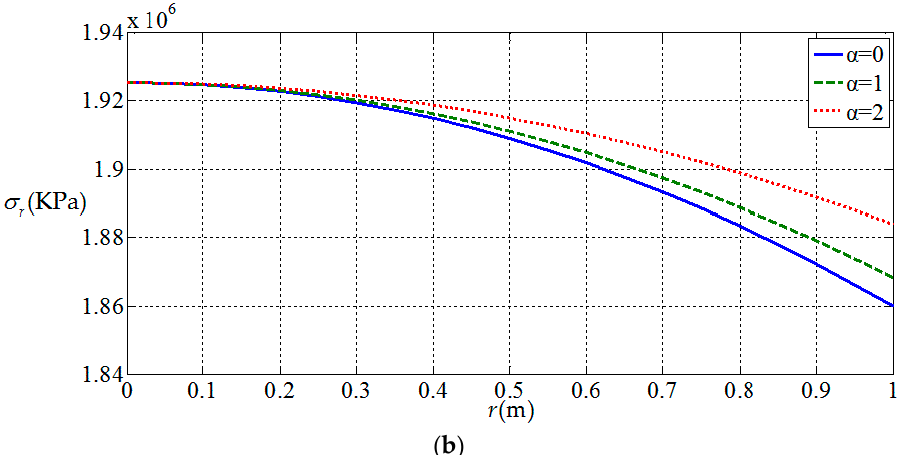
Figure 11. Variation of elastic stress with coordinates r at z = h /4. ( a ) z -direction stress σ z ( r , h /4 ) at z = h /4; ( b ) radial stress σ r ( r , h /4 ) at z = h /4.